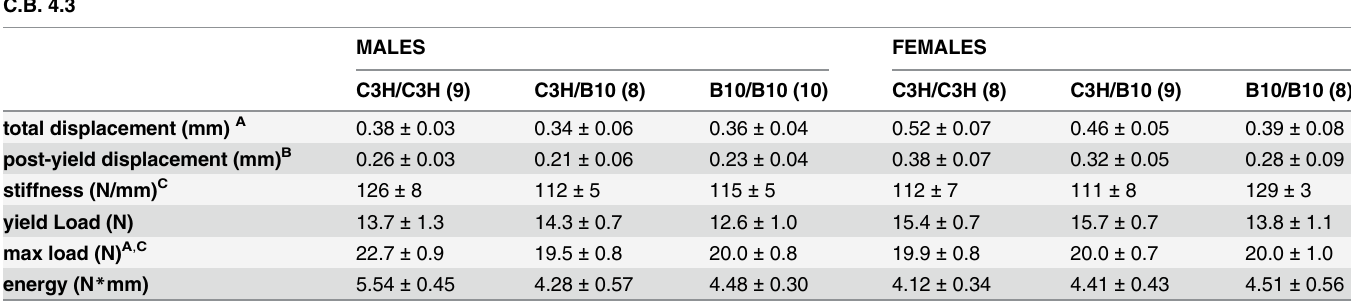
Table 3. Whole-Bone Mechanical Performance of C.B.4.3 Mice.